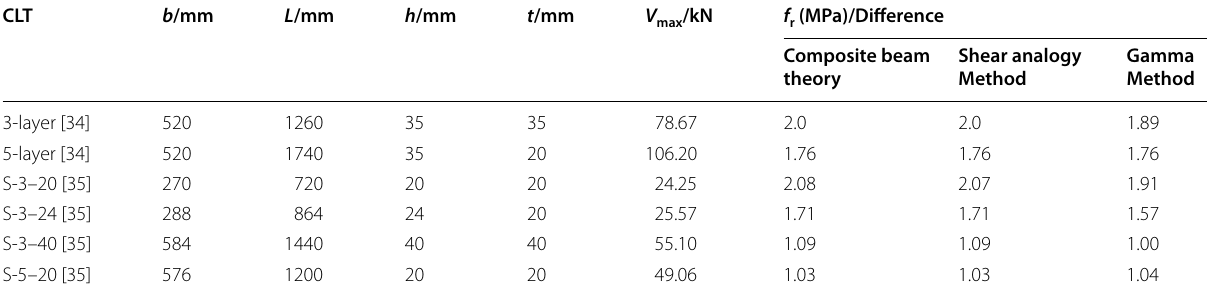
Table 5 Comparation of the rolling shear strength obtained by calculation based on short-span loading test CLT b